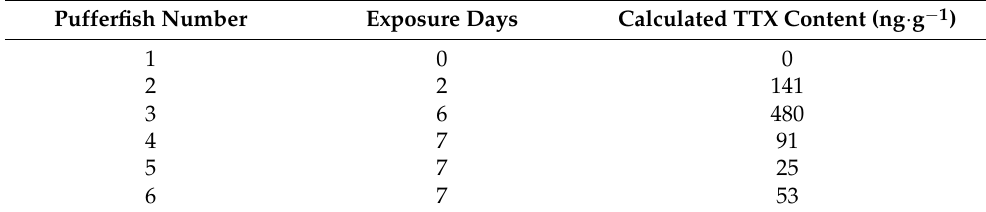
Table 2. In vivo SPME results of